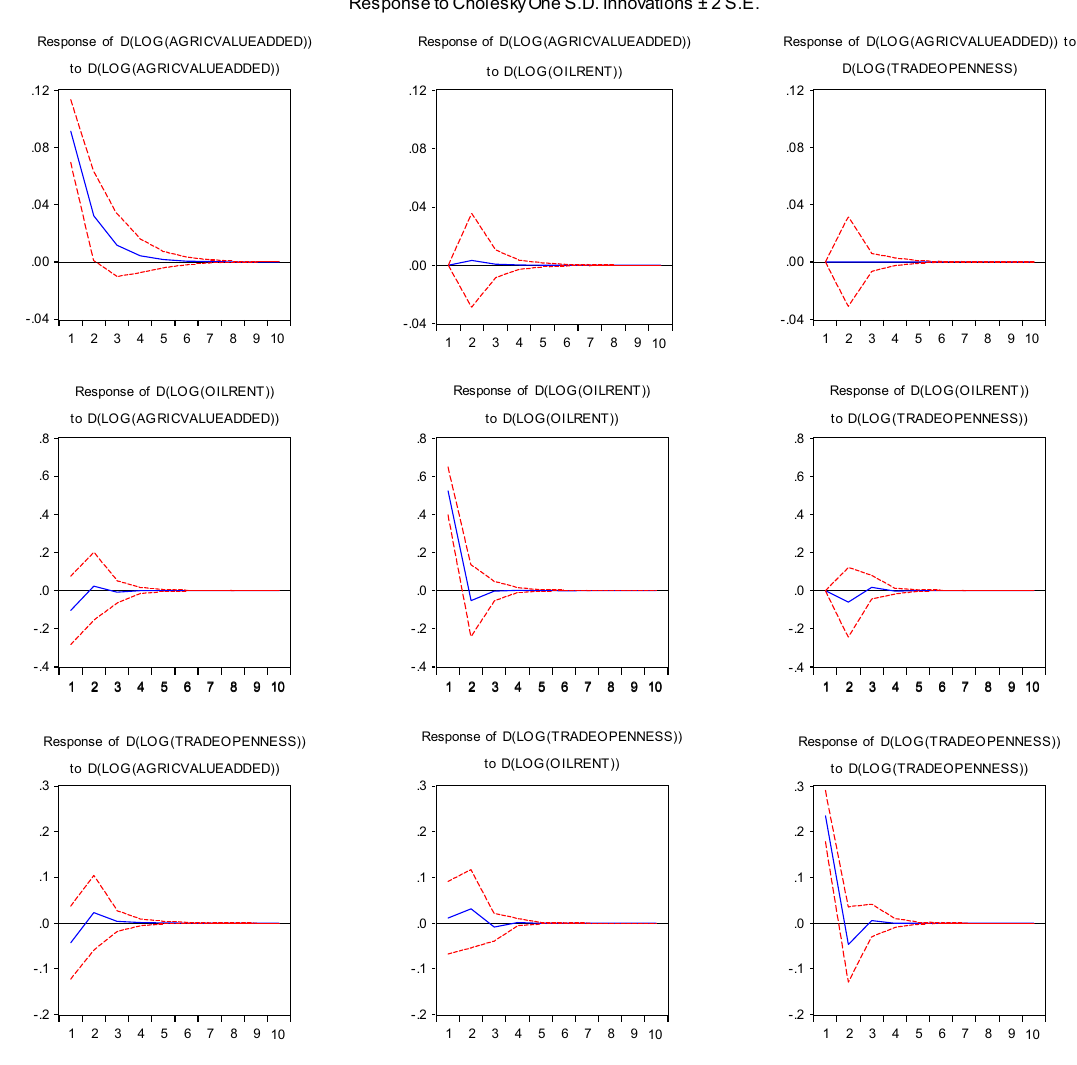
Figure 2: Impulse